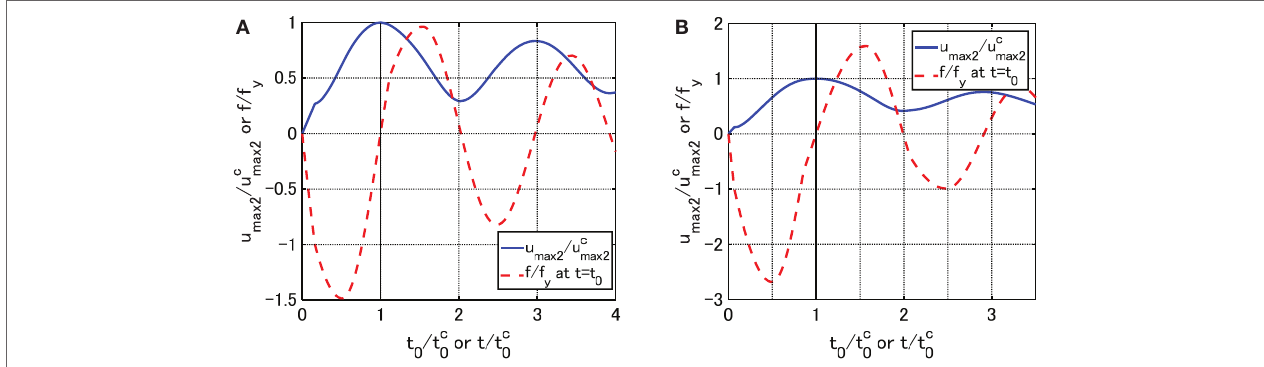
FIGURE 13 | Comparison of the responses under the critical double impulse and the equivalent one-cycle sine wave for the model of α = 0.3, h = 0.1 and the input level of V / V y = 3.0, (A) deformation time history, (B) restoring-force time history, and (C) force–deformation relation.